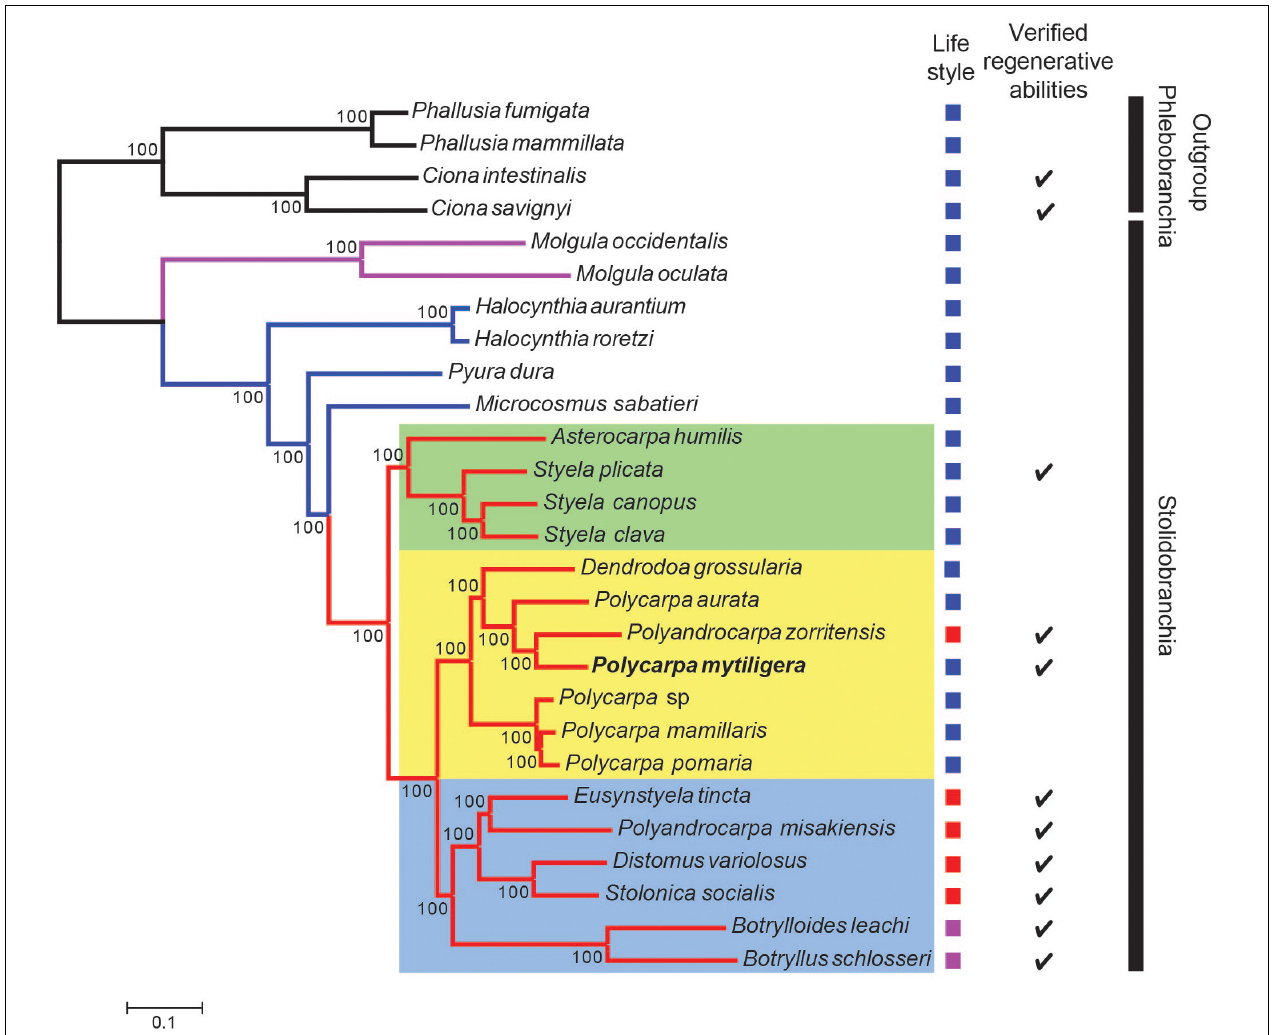
FIGURE 6 | P. mytiligera demonstrates a close phylogenetic relationship to colonial species. Phylogenetic relationships between Stolidobranchia, with a focus on Styelidae, inferred from 182 protein coding genes under the LG + C60 + F + G model. Newly sequenced P. mytiligera is shown in bold. Bootstrap supports are indicated near the corresponding nodes. Red branches indicate Styelidae species, blue Pyuridae species, purple Molgulidae species, and black Phlebobranchia species used as outgroup. Colored squares represent different clades. Left column: life-style modes as documented in the literature (blue: solitary, purple: colonial, red: colonial with separated zooids). Right column: checkmark indicates species where regenerative ability were documented in the literature (see also Supplementary Figure 5